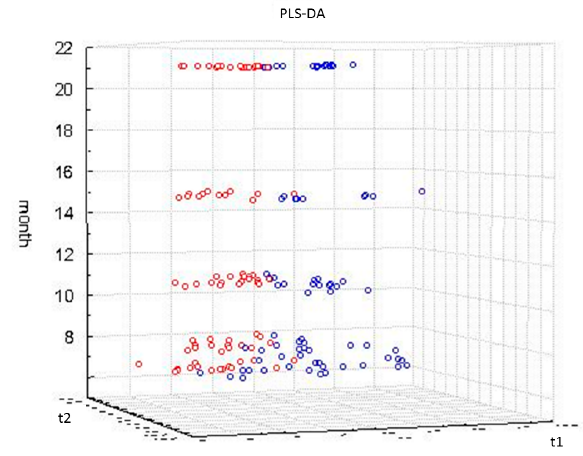
Figure 2. A three-dimensional PLS-DA scores plot of rat urine samples of life-long exercise group B (red colored) and sedentary group A (blue colored) projected in time for five sampling time points, namely 2,3,5,6 and 7 (from down to up), corresponding to 2,3,6,10 and 16 months of training. The Z axis shows the rat age in months while the horizontal axes show t1 vs. t2 and describe the sample variability where the exercise effect is shown.